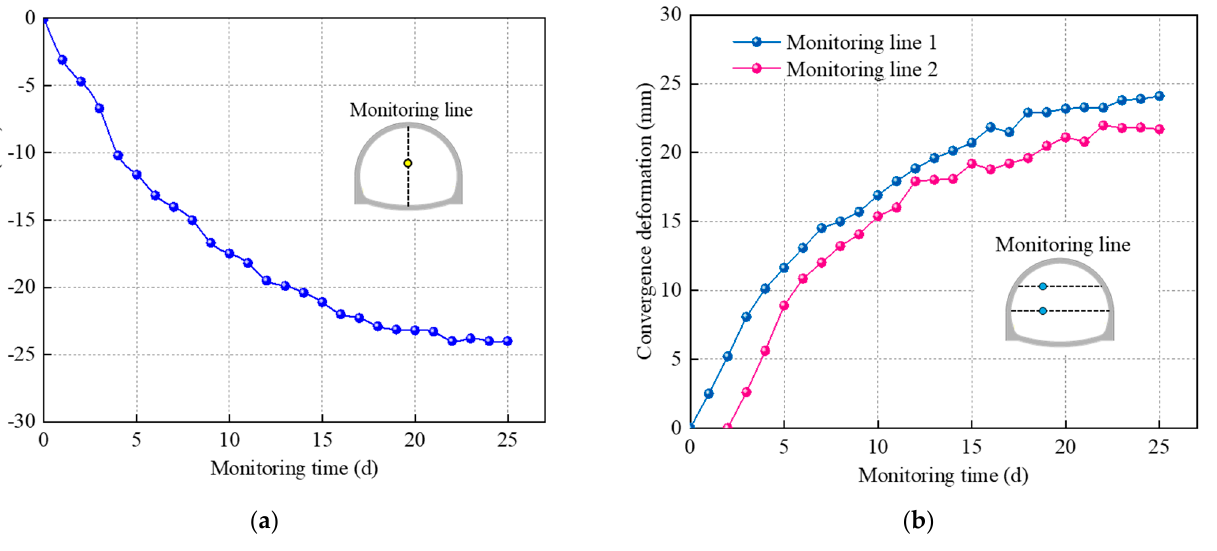
Figure 12. Displacement monitoring curve of primary lining. ( a ) variation curve of vault settlement; ( b ) variation curve of convergence deformation.